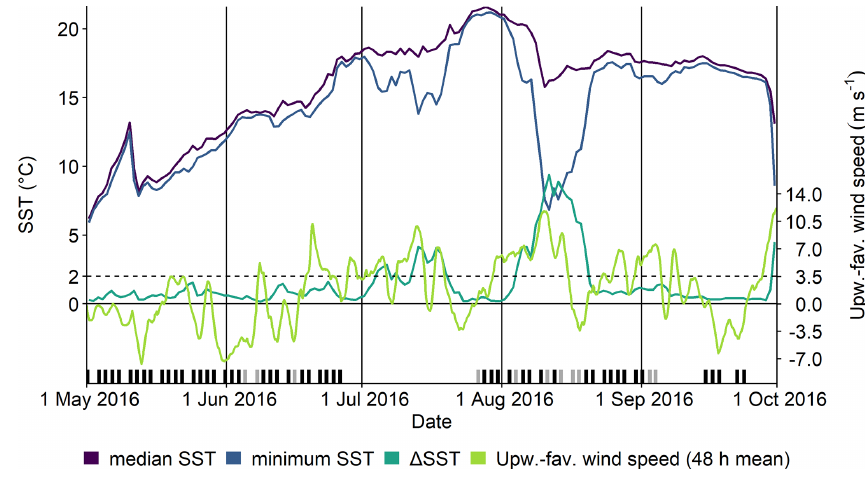
Figure 4. Time series to demonstrate upwelling detection within the Go-SE box. Purple and blue lines are median and minimum model SST along the transect of SOOP Finnmaid ; the turquoise line shows their difference ( (cid:49) SST). The green line represents the running mean of upwelling-favourable wind speeds, calculated every 3h for the last 48h, respectively. The dashed black line indicates the chosen thresholds of the (cid:49) SST and wind criteria, respectively (2 ◦ C, 3.5ms − 1 ). Each passage of SOOP Finnmaid through the box is marked with a black dash at the bottom. Grey dashes mark when the ship took the western route around Gotland, thereby missing this particular box on the east side. A strong upwelling event in August is observed with small data gaps due to SOOP Finnmaid taking the western route. Another event in July is missed because of a sensor